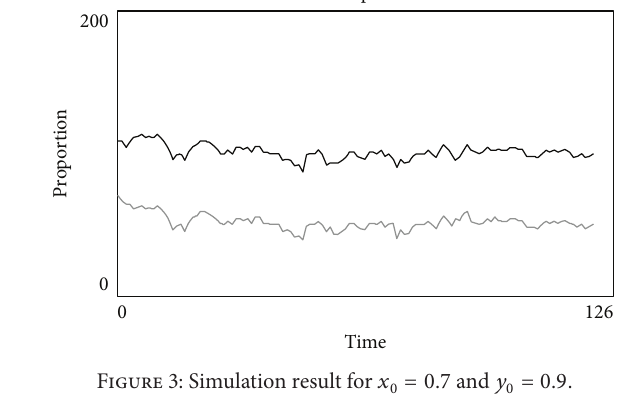
Figure 3: Simulation result for 𝑥 0 = 0.7 and 𝑦 0 = 0.9 .